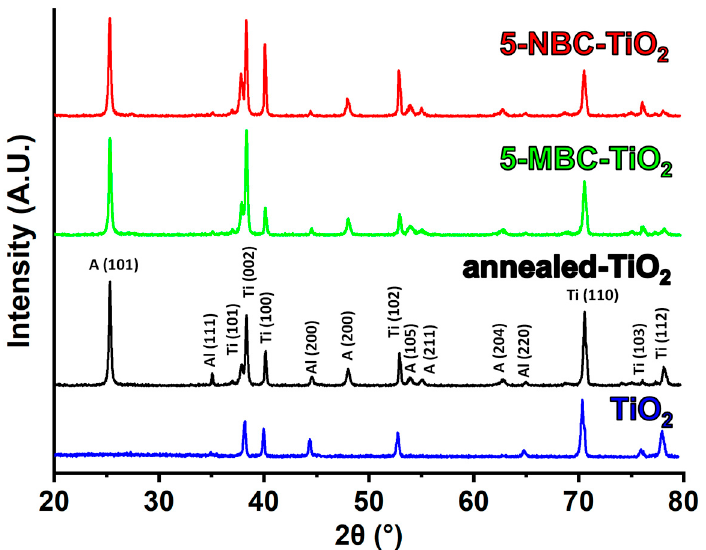
Figure 6. XRD pattern of as-formed (blue line) and crystalline TiO 2 nanotubes (black line), 5-MBC- TiO 2 (green line), and 5-NBC-TiO 2 (red line). The peak labels are indicated as follows: A = Anatase, Ti = Titanium (substrate), Al = Aluminum (sample